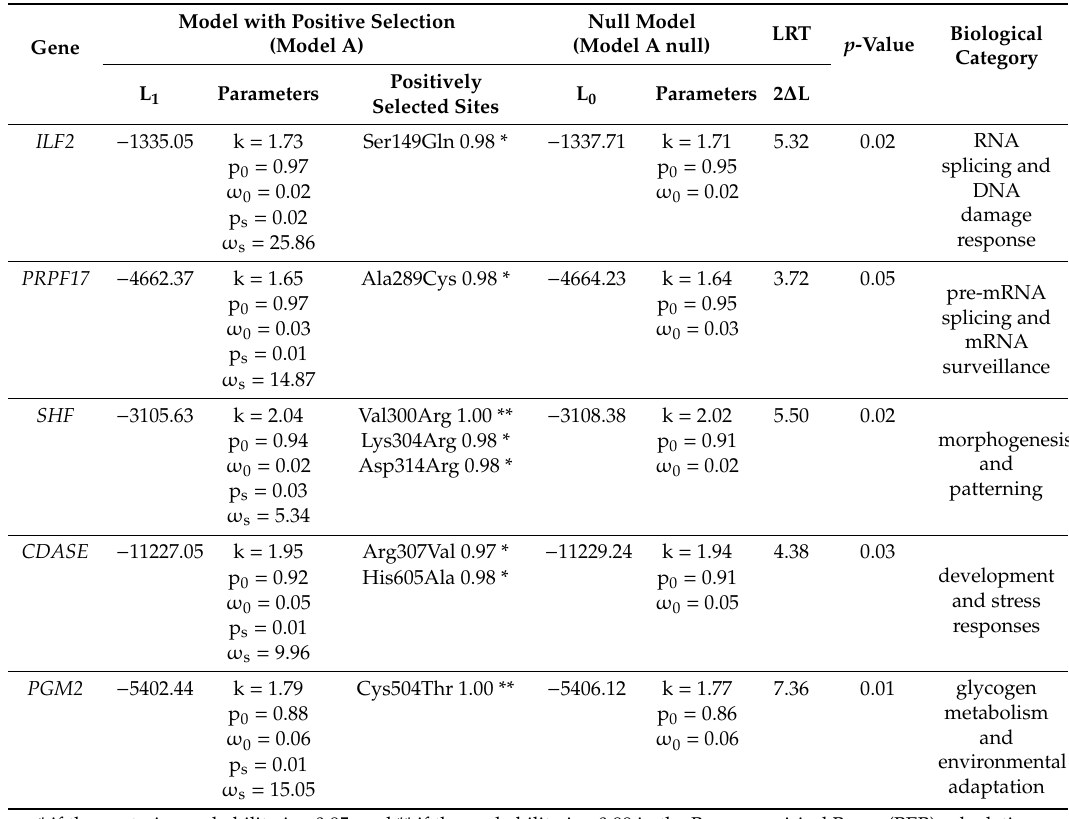
Table 2. Results of positive selection analysis for the branch of the genus